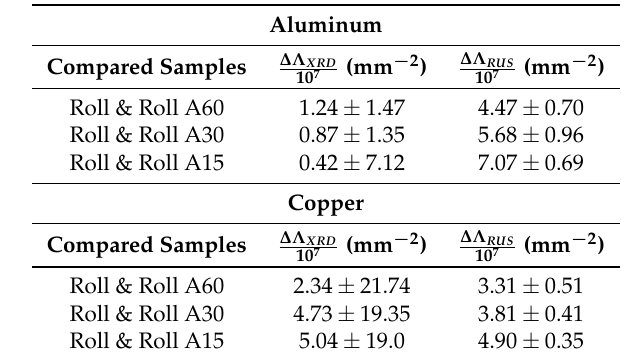
Table 3. Comparison of XRD and RUS measurements of relative dislocation density for the Al and Cu samples. Errors for XRD measurements are calculated with the contribution of the Rietveld refinement results and the statistical error from the repetition of the experiment in two pieces of the same sample (longitudinal and transversal). These errors are large and preclude a sample-to-sample comparison. By contrast, the errors associated with the acoustic measurements are sufficiently small that a quantitative comparison can be confidently